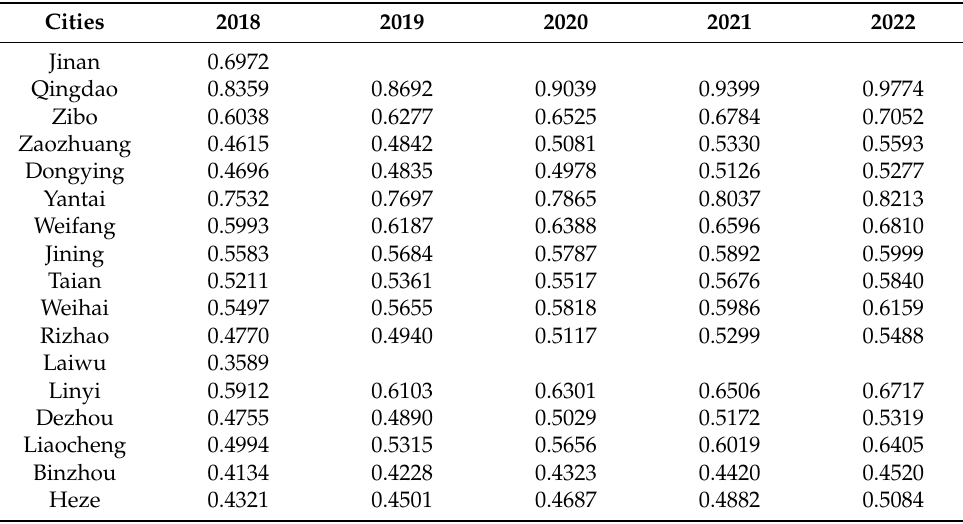
Table 5. Forecast of coupling coordinative degree among the three